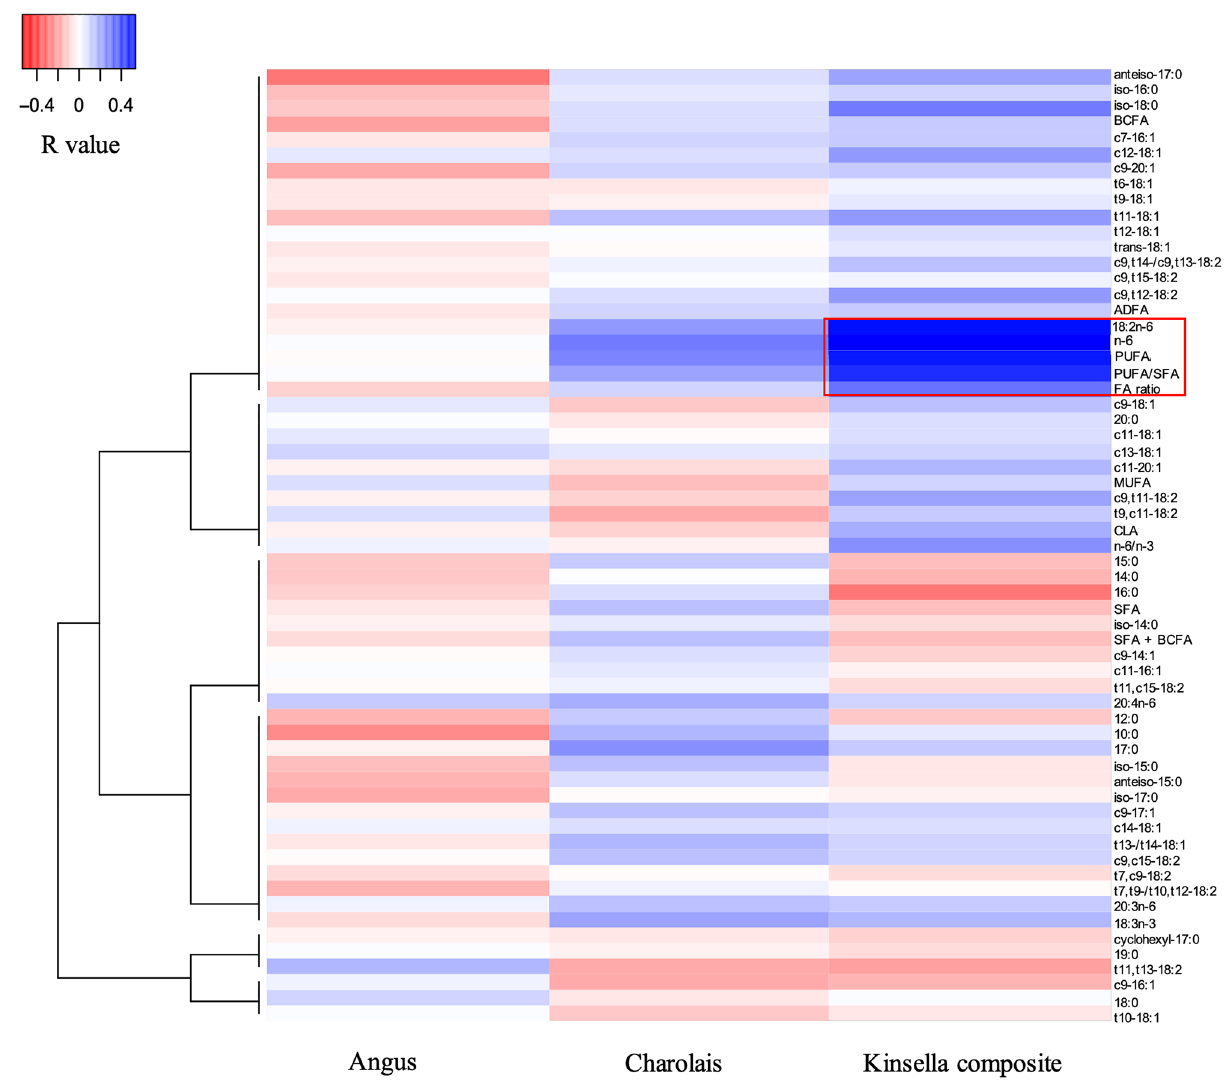
Figure 2. Correlations between FA profiles and RFI for the three breeds. The correlations of statistical significance ( p < 0.05) identified from the KC breed were highlighted in red